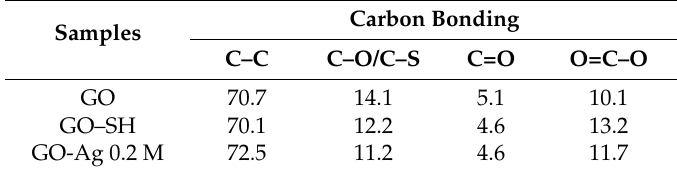
Table 1. Bonding composition percentage of X-ray photoelectron spectroscopy (XPS) survey.